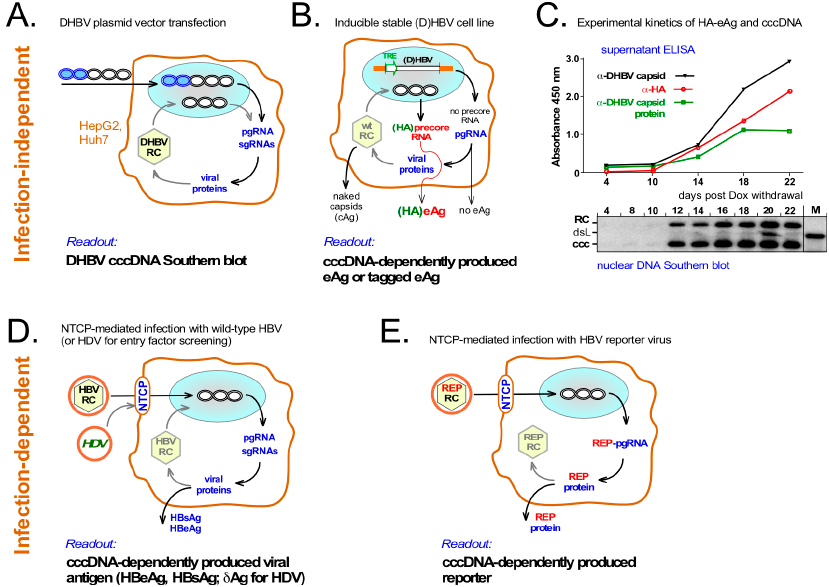
Figure 5. Surrogate models to overcome low production and poor specific detection of HBV cccDNA. ( A ) Transient transfection of DHBV expression vectors into human hepatoma cells. DHBV produces much more cccDNA than HBV in the same human hepatoma cells [36]. Transfected plasmid